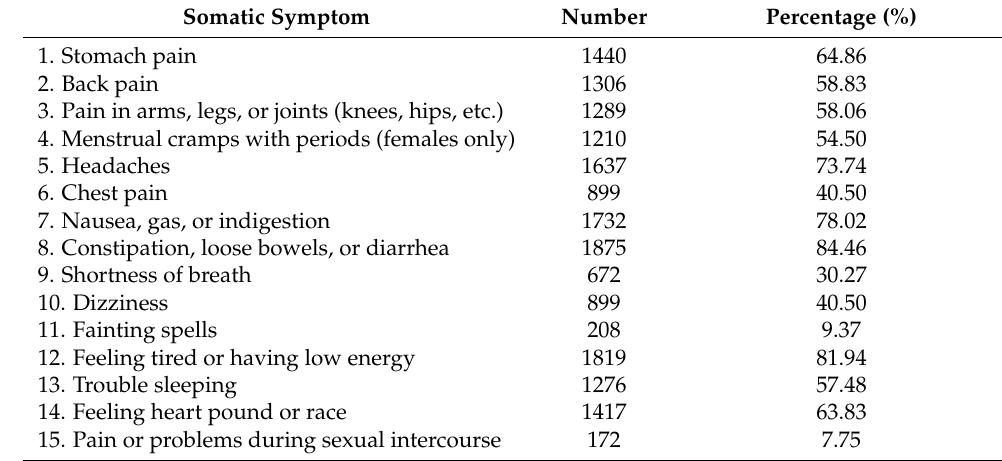
Table 2. Individual symptom conditions among medical students with somatic symptoms.